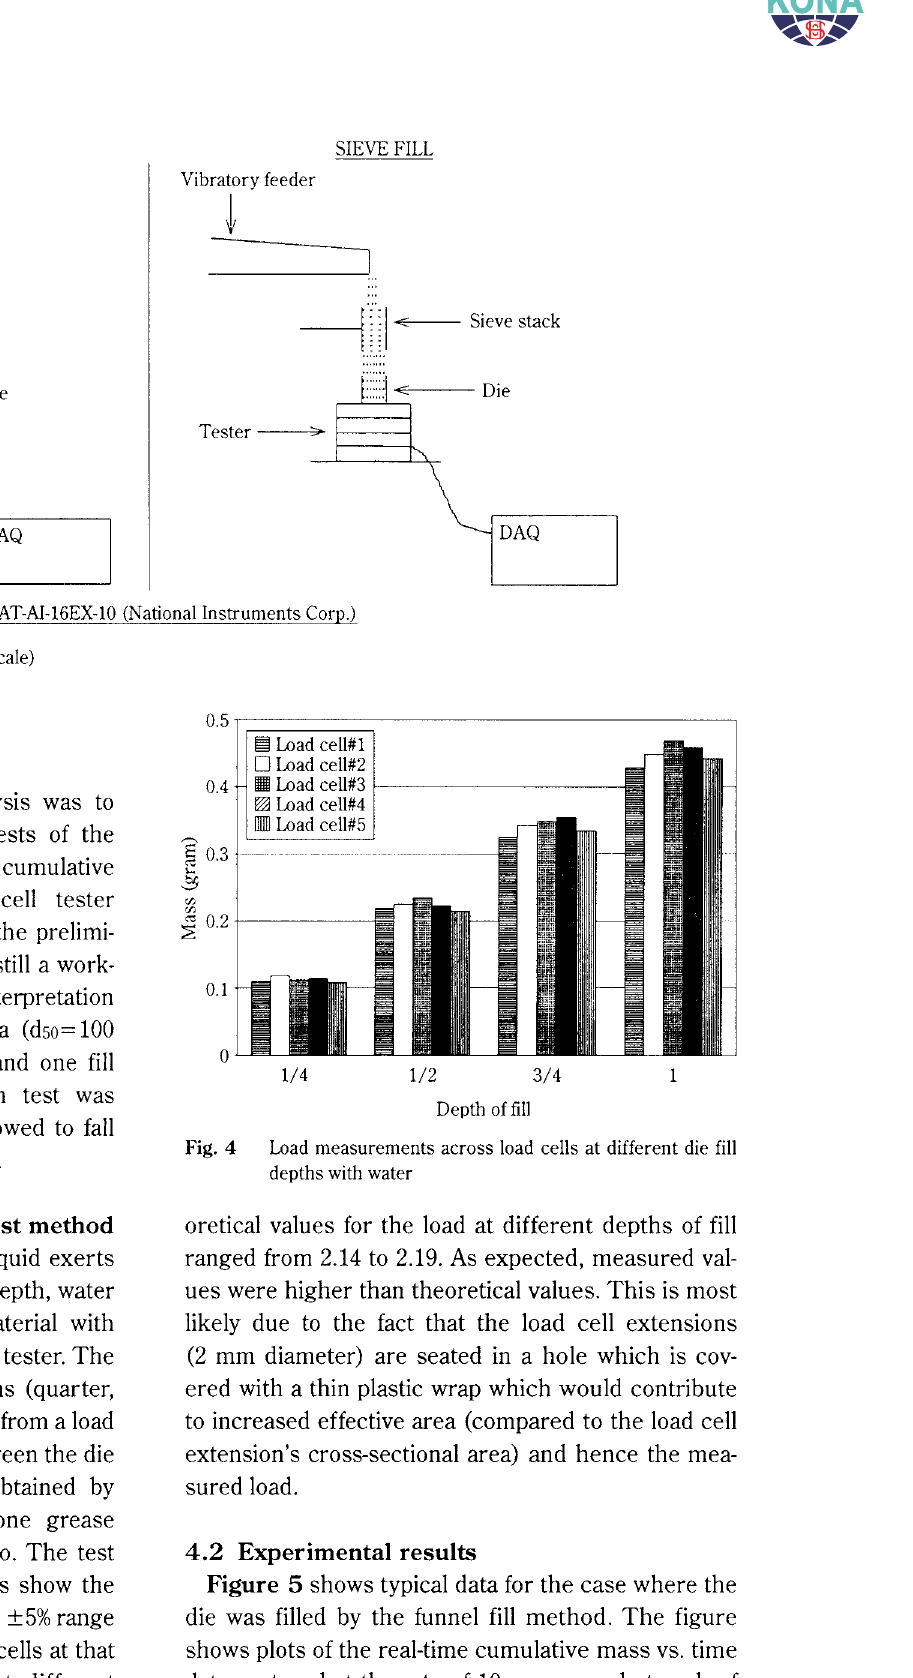
Schematic of test apparatus set-up (not to scale)